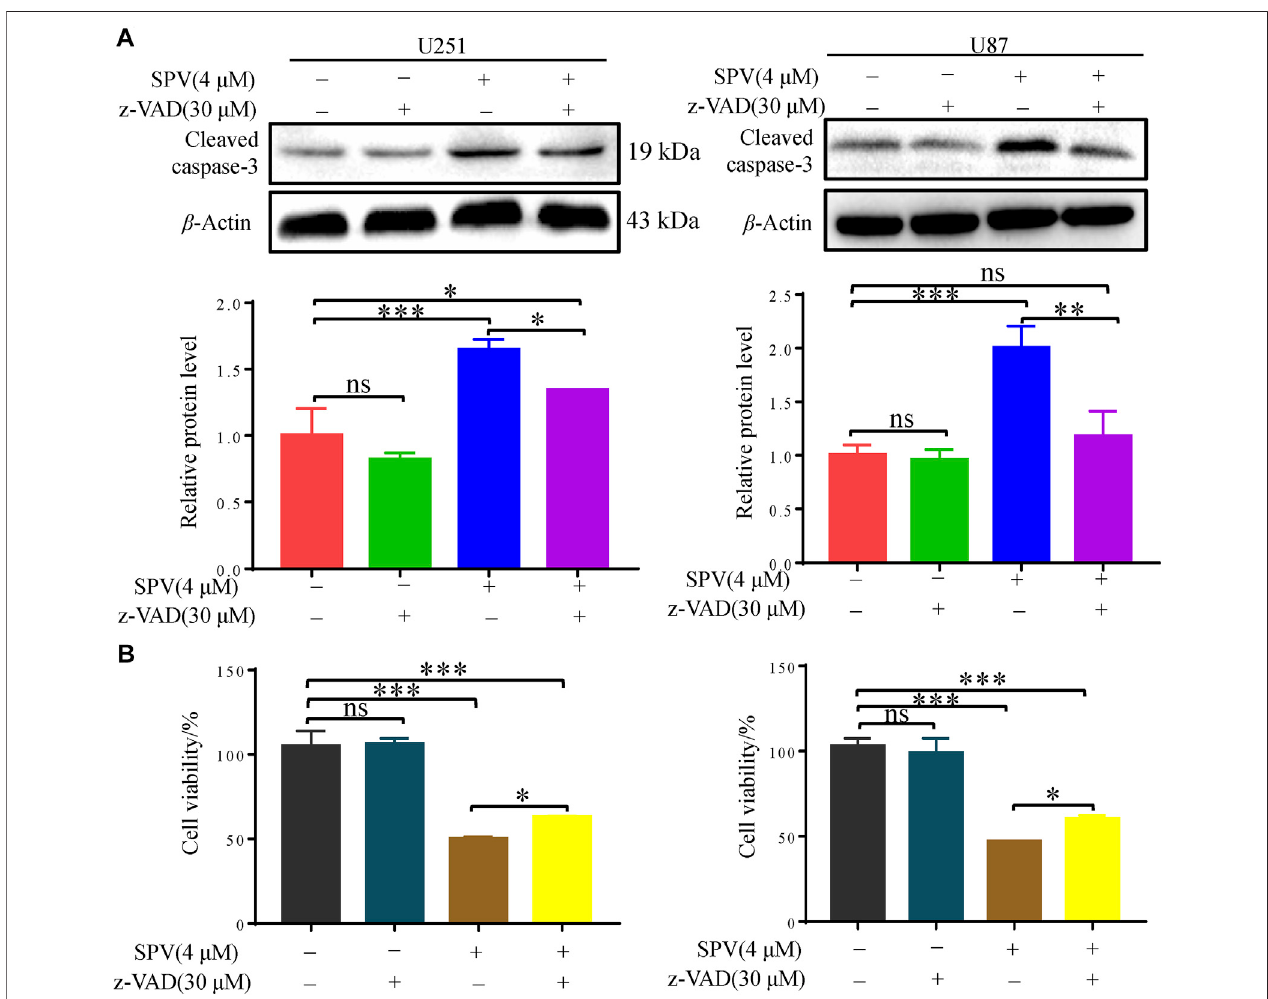
Figure 4 | Sempervirine triggered apoptosis in glioma cells, and inhibition of apoptosis decreased sempervirine-induced cell death. (A) z-VAD (30 μ M) was added to cells 2 h before sempervirine treatment. After 48 h, cleaved caspase-3 was analyzed by Western blotting. (B) z-VAD was added to cells 2 h before sempervirine treatment. Then, cells treated with sempervirine for 48 h. Cell viability was determined by MTT. Data are presented as the Mean ± SD ( n (cid:2) 3). * p < 0.05, ** p < 0.01 and *** p < 0.001 compared with the control group.